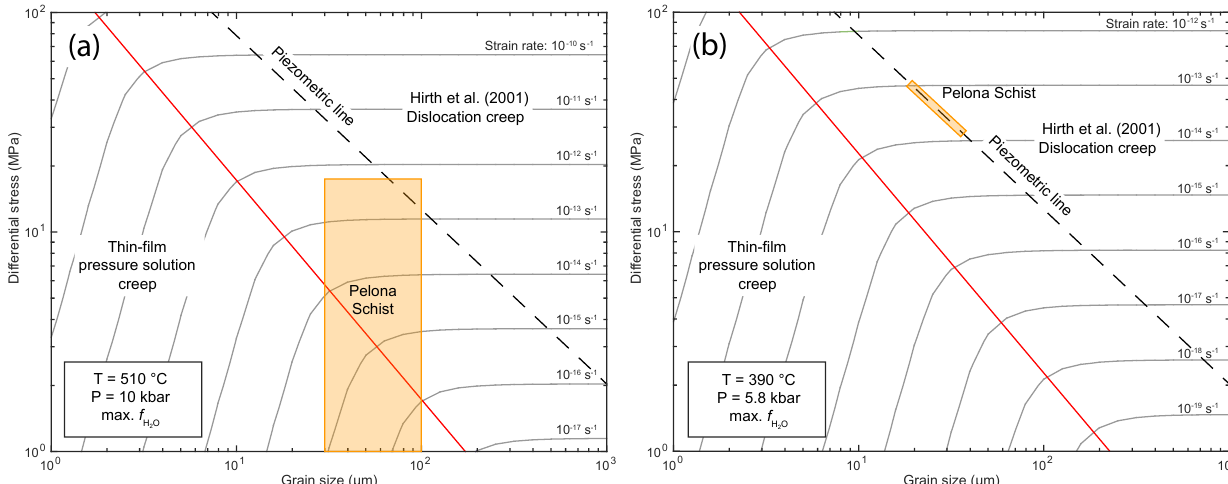
Figure 14. Deformation mechanism maps for (a) D2 and (b) D3. In both maps, the red line marks the boundary between the regime of quartz pressure solution and that of quartz dislocation creep, the black dashed line is calculated using the recrystallized quartz grain size piezometer (Stipp and Tullis, 2003), and the orange shaded area is the Pelona Schist in the grain size–stress space. See text for discussion.